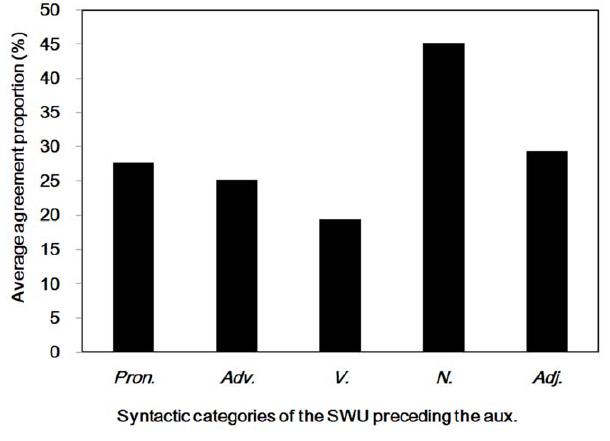
Figure 3. Preceding words and the auxiliary words. Average agreement proportions for word boundaries between the different preceding syntactic categories of SWU and the auxiliary words. Pron.=pronouns; Adv.=adverbs; V.=verbs; N.=nouns; Adj.=adjec- tives; Aux.=auxiliary words.